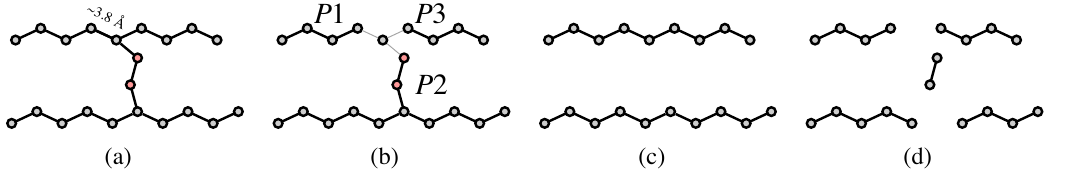
Figure 1. Fork pruning procedure. ( a ) Regularization of the nodes of the MSTree to be spaced by 3.8 Å. The anchoring C α defining the reference position to regularize the positions are defined by nodes